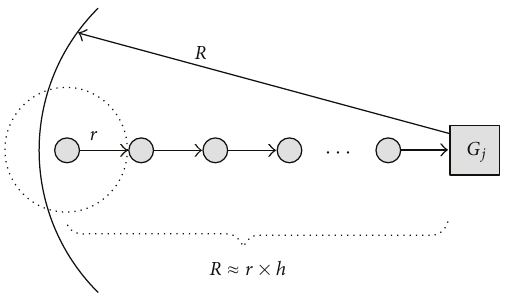
Figure 3: Approximating the cluster size from the number of hops and average node degree of each sensor node.